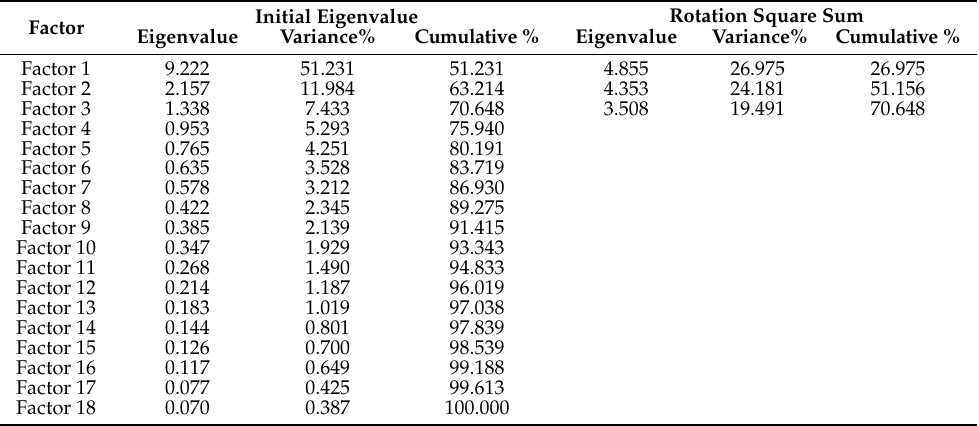
Table 2. Results of factor analysis.